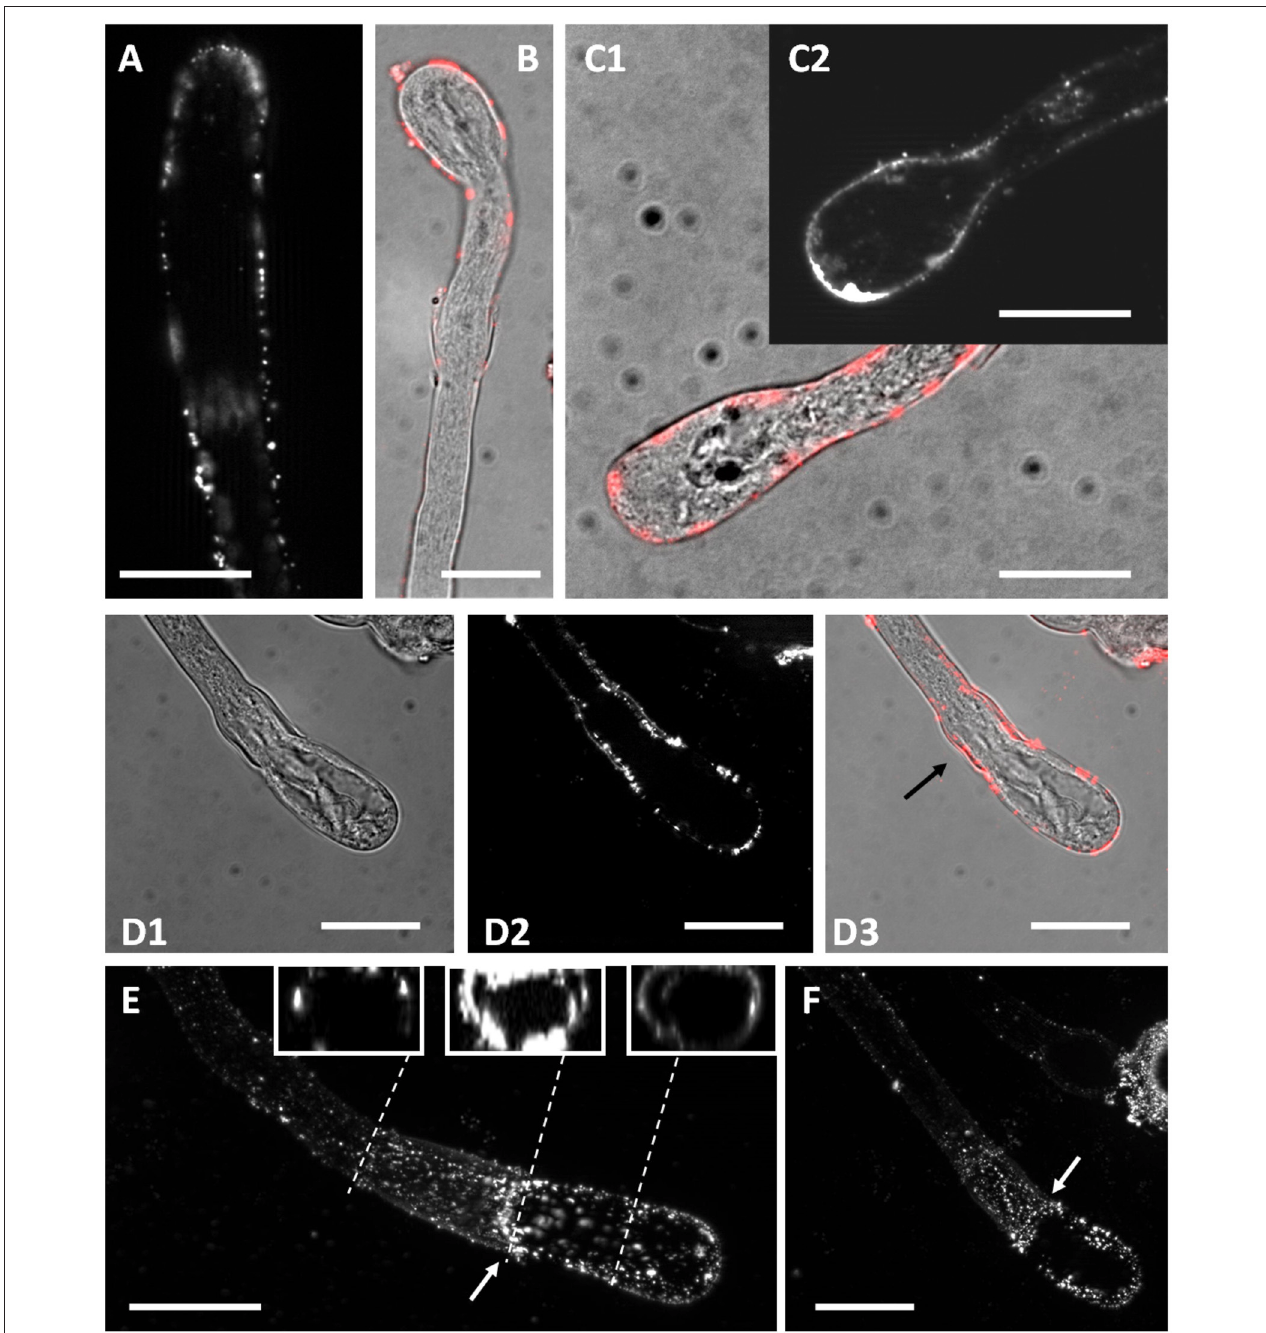
FIGURE 12 | Distribution of callose synthase in control and Spm-treated pear pollen tubes. (A) Callose synthase is present as dots or patches along the entire border of control pollen tubes. (B) At the balloon-like step, callose synthase accumulates in the spherical domain. This image is a merge of phase contrast and immunofluorescence (red) pictures of the same pollen tube. (C1,C2) Accumulation of callose synthase in the apical domain is more evident at the transition between the balloon-like and the shovel-like step. The image in (C1) is a merge of immunolocalized callose synthase (red) with phase contrast view of the same pollen tube. The image in (C2) is an immunofluorescence view of another pollen tube. (D1–D3) Accumulation of callose synthase in the neck (arrow) becomes evident when pollen tubes develop into the snake shape and start assuming the shovel shape. (E–F) Two additional views of Spm-treated pollen tubes showing a consistent accumulation of callose synthase in the neck region (arrows), with an annulus-like configuration. Bars = 10 µ m. The insets in Figure 11E show three reconstructions from a Z-series stack demonstrating that the annulus does not have uniform fluorescence intensity. Data are representative of three independent experiments.